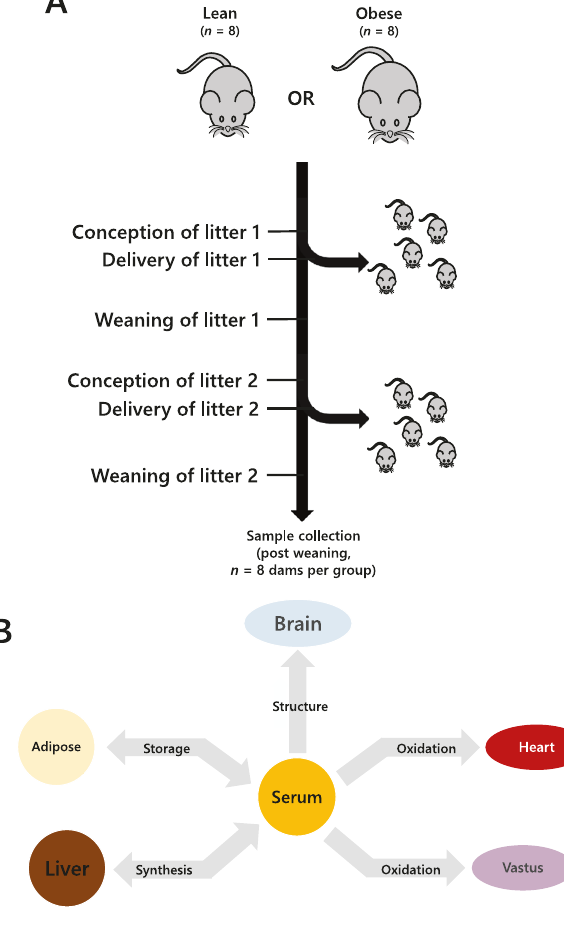
Fig. 1 The tissue network of the mouse model of obese-GDM used in the present study. A Schematic representation of the mouse model showing the groups, pregnancies and weaning. B The network that describes the lipid traf fi c associated with this model, including tissues whose activity is typically associated with diet- driven diabetes. The termini represent traf fi c fl ow from synthesis (liver), for structural purposes (CNS), fatty acid oxidation (heart, vastus, liver) and storage (adipose). This metabolic relationship between tissues was used as the structure of the network for all analyses in the present study. Lean refers to mice fed exclusively a diet of normal chow ad libitum whereas Obese refers to mice fed a high fat diet drawn from mainly dairy fat